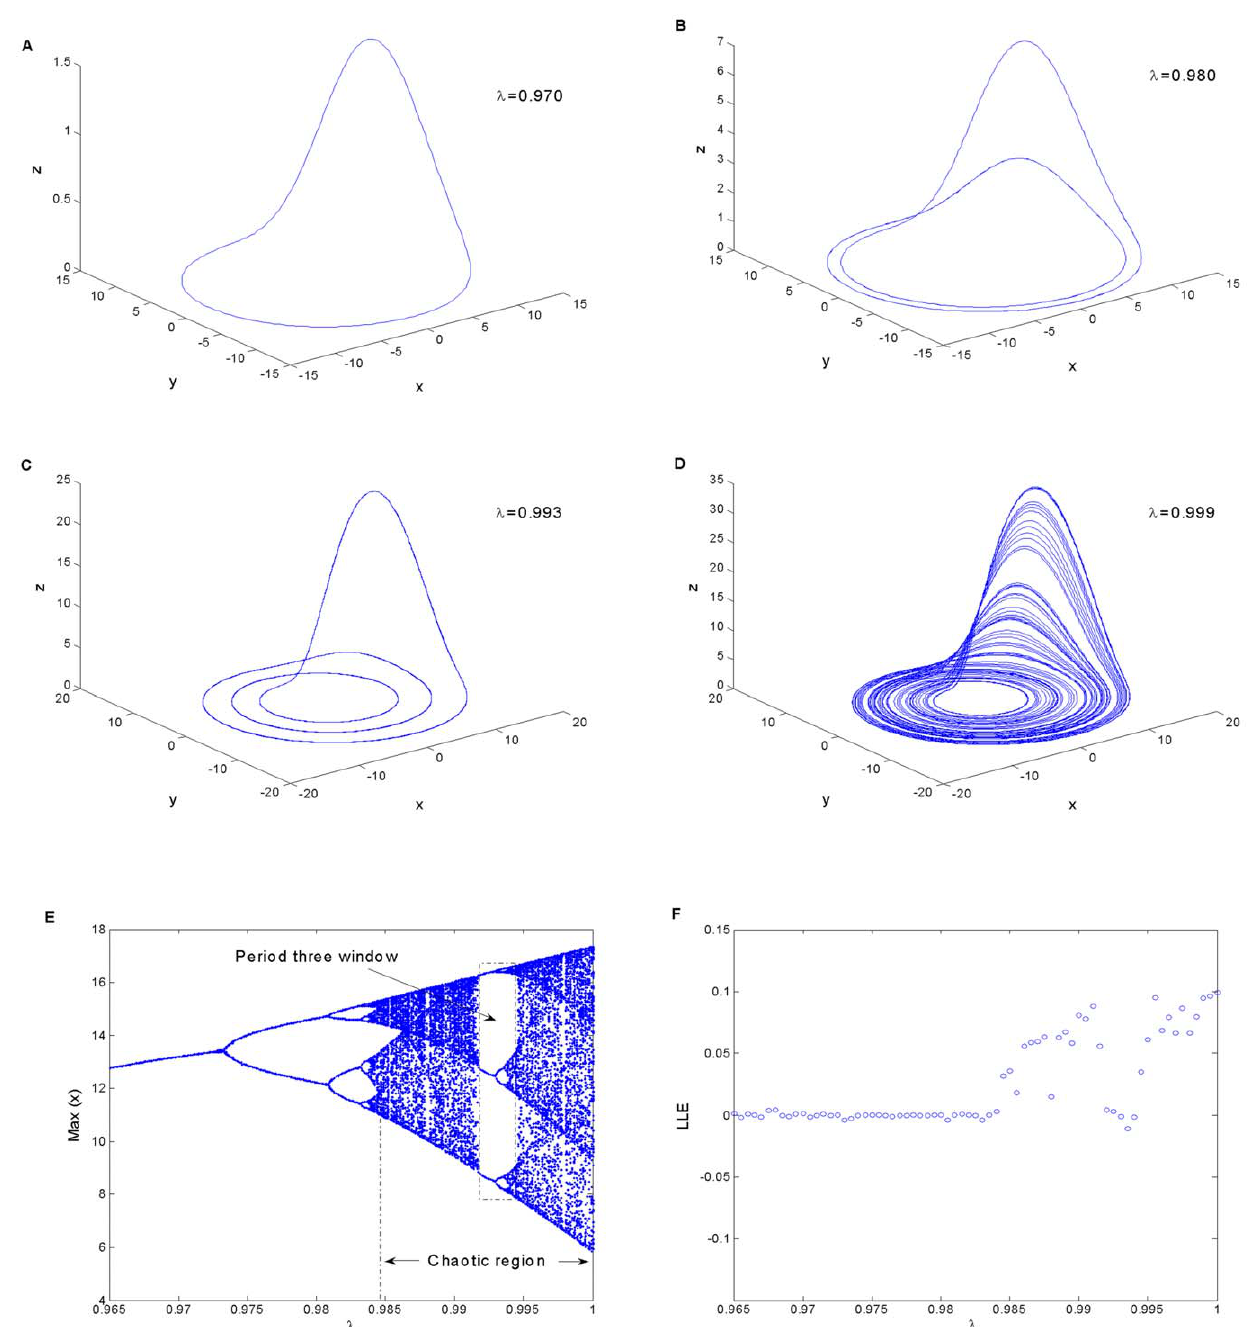
Figure 6. The Ro¨ssler oscillator running under globally slow transcriptional dynamics. A. Period one motion. B. Period two motion. C. Period three motion. D. Chaotic motion. E. Diagram of period doubling bifurcation. F. Plot of the largest Lyapunov exponent against the system orders. LLE indicates chaotic motion, limit cycle (or quasiperiodic motion) and fixed point attractor with positivity, zero and negativity, respectively.